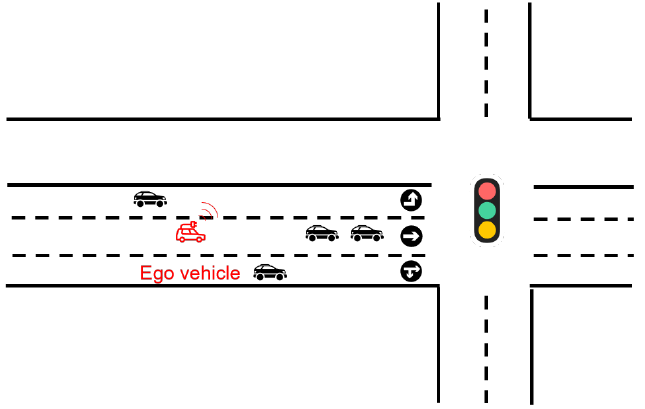
Figure 4. The driving scenario for the ego vehicle in a single intersection.